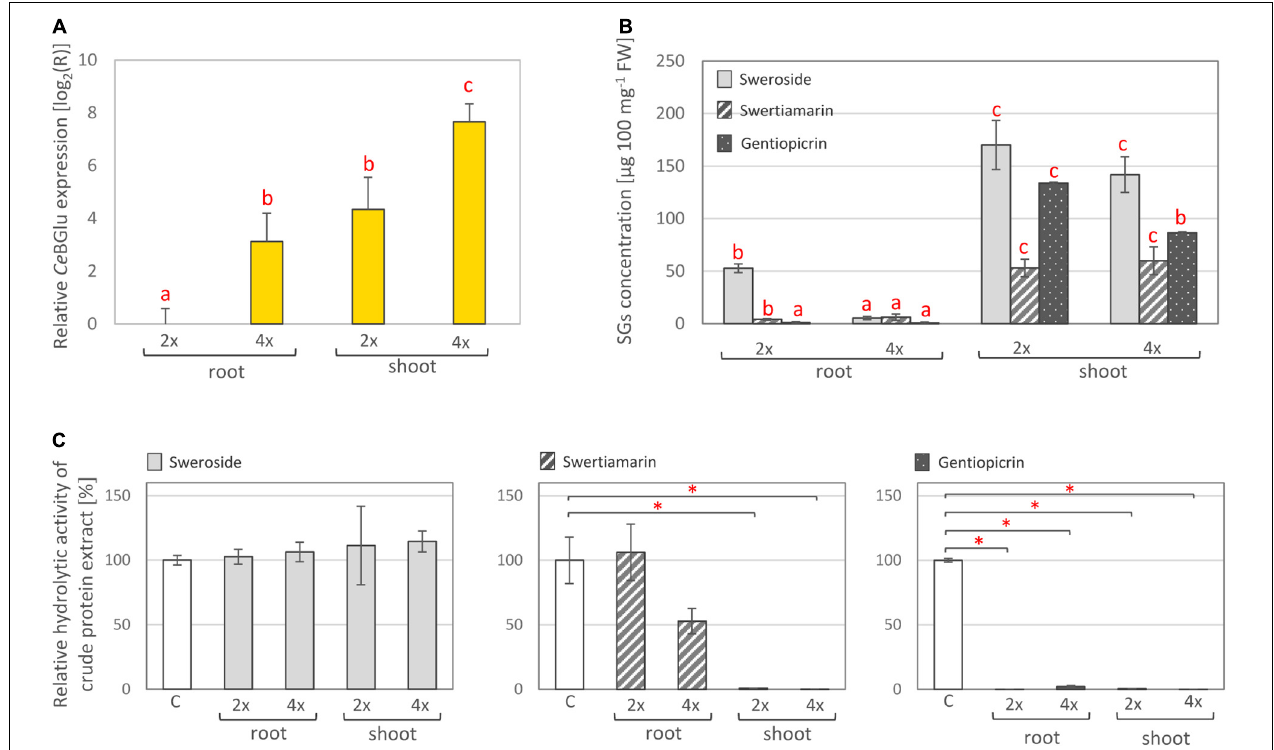
FIGURE 5 | (A) Relative expression of CeBGlu in shoots and roots of in vitro grown C. erythraea diploid (2 × ) and tetraploid (4 × ) plants. Values are normalized to the CeBGlu expression level in roots of diploid plants. Letters above the bars denote significant differences according to Fisher LSD test at p < 0.05. (B) Content of major secoiridoids in shoots and roots of diploid and tetraploid C. erythraea plants. Values represent means ± SE ( n = 3). Letters above the bars denote significant differences according to Fisher LSD post hoc test at p < 0.05, for each compound independently. (C) Hydrolytic activity of total proteins isolated from shoots and roots of diploid and tetraploid C. erythraea genotypes, using sweroside, swertiamarin and gentiopicrin as substrates. The bars indicate the amount of substrates (%) not enzymatically hydrolyzed in an in vitro enzymatic assay. Control group (white bars), where no protein extract was added, was set to 100%, and all the values are presented relatively, in respect to control. Data are mean ± SD ( n = 3). Red asterisks denote significantly different adjusted p -values, * p <